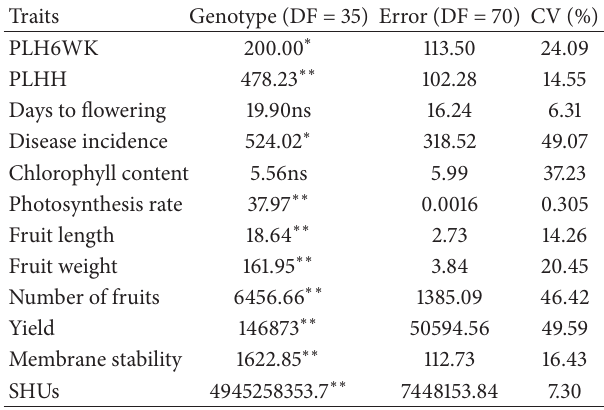
Table 4: Analysis of variance for 11 characters for the 36 Capsicum spp